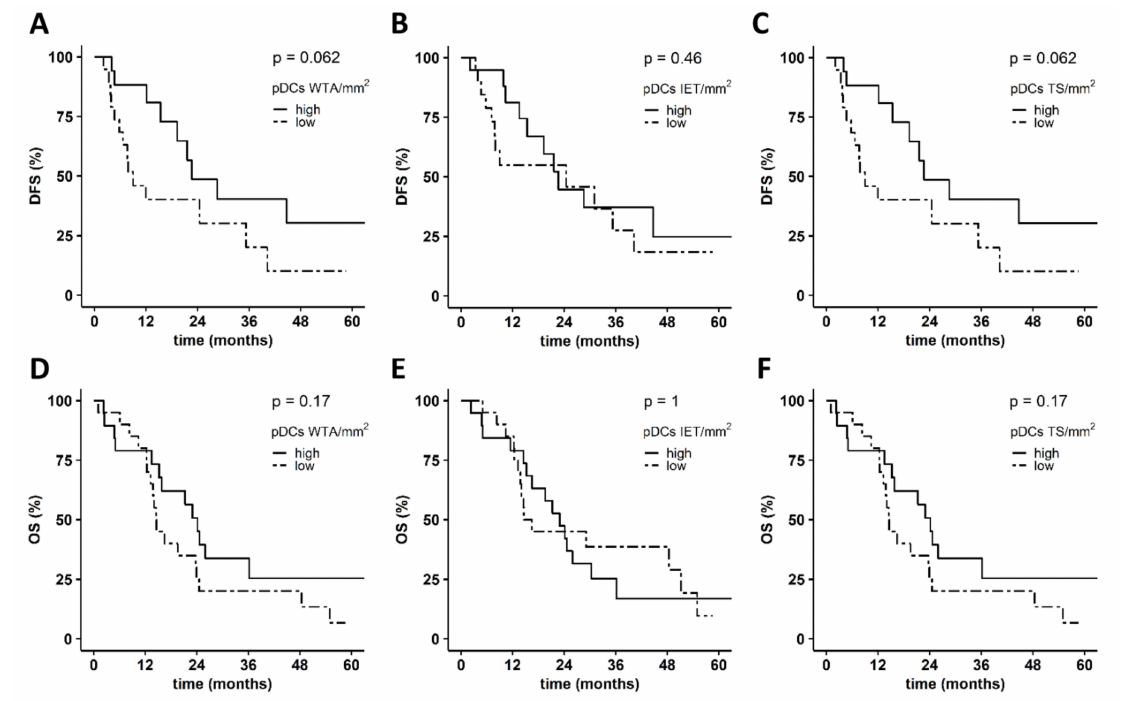
Figure 5. Association between the density of pancreatic ductal adenocarcinoma (PDAC)-infiltrating plasmacytoid dendritic cells (pDCs) and clinical outcome of patients. Kaplan–Meier curves illustrate the association between whole tumor area (WTA)-, intraepithelial tumor (IET)-, and tumor stroma (TS)-infiltrating pDCs ( n = 58) and ( A – C ) disease-free survival (DFS) or ( D – F ) overall survival (OS). Upper tercile (density>2/3 of the patients in the analyzed cohort; solid line) and lower tercile (density ≤ 1/3 of patients in the analyzed cohort; dash line) were compared. p values were calculated using the log-rank test, and p ≤ 0.05 was considered